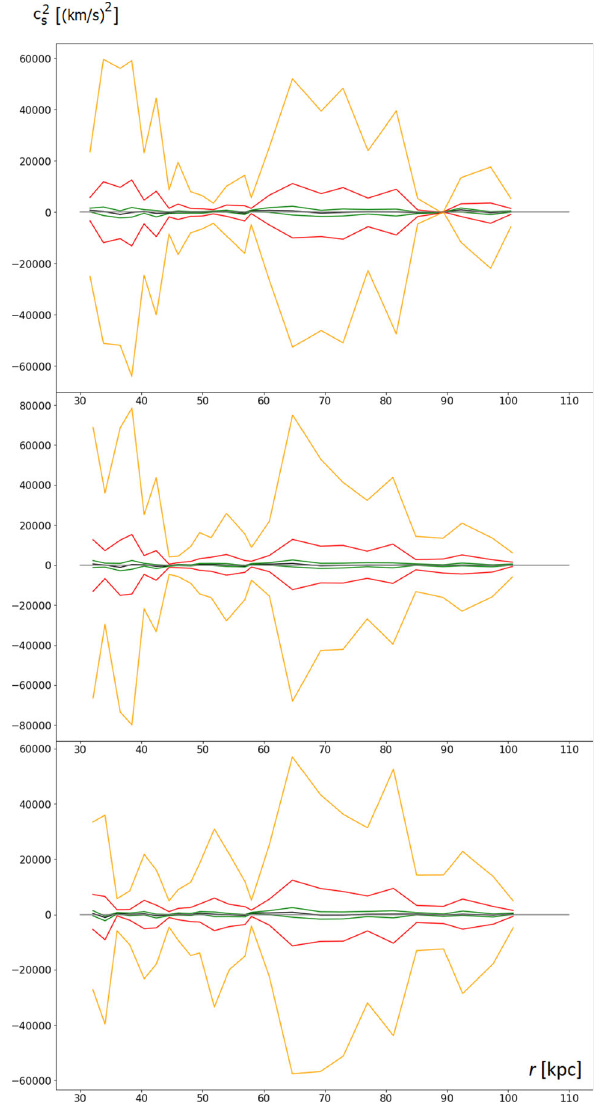
Fig. 6 Median (blackline)andlowerandupperboundsof68% (green lines),95% (redlines)and99% (orangelines)confidenceintervalsof c 2 s calculated using five-point scheme for the calculation of derivatives for three combinations of distance of Sun from the galactic center and Sun orbital velocity around the galactic center: ( R 0 = 8 . 0 kpc, v 0 = 200 km/s) (top), ( R 0 = 8 . 3 kpc, v 0 = 244 km/s) (middle) and ( R 0 = 8 . 5 kpc, v 0 = 220 km/s) (bottom)